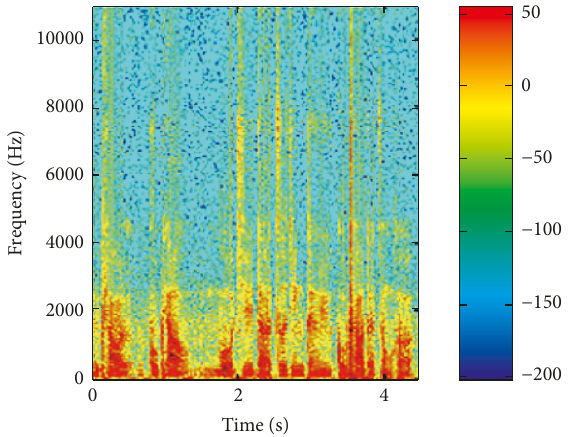
Figure 5: Time Domain sequence waveform of outlier data- containing information flows obtained by the CCPSWNIDA